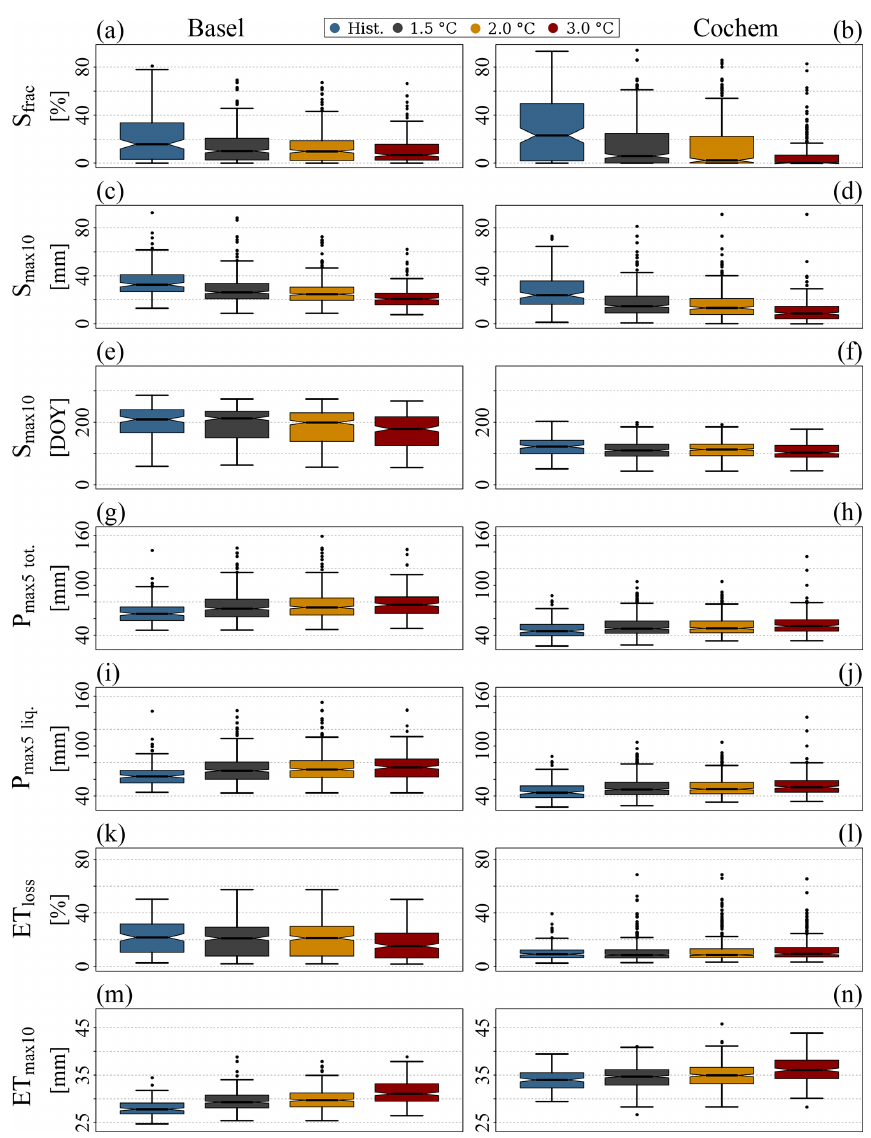
Figure 6. Estimated importance of snowmelt during peak flow formation ( S frac ; a and b ), magnitudes (c, d) and timing (e, f) of annual 10d snowmelt maxima ( S max10 ), magnitudes of annual total (g, h) and liquid (i, j) 5d precipitation maxima ( P max5 ), estimated evapotran- spiration loss during the genesis of annual streamflow maxima (ET loss ; k and l ) and magnitudes of annual 10d actual evapotranspiration maxima (ET max10 ; k and l ) for sub-basins at Basel (left column) and Cochem (right column) under selected warming levels (14 GCM–RCP realisations reach 1.5 ◦ C, 13 reach 2 ◦ C and 8 reach 3 ◦ C